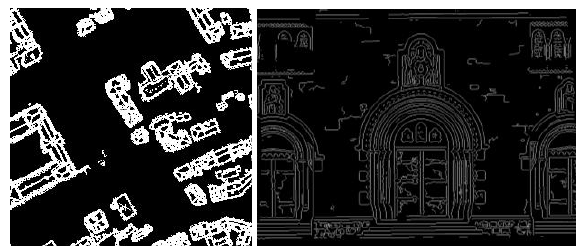
Figure 5. Geometric edge regions in aerial and terrestrial